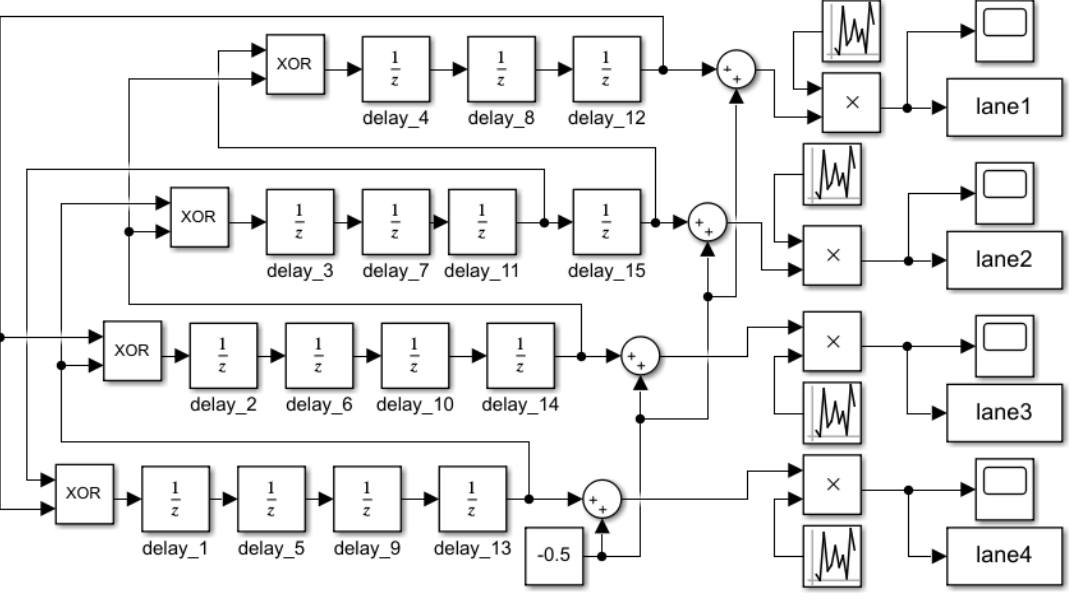
Appl. Sci. 2022 , 12 , x FOR PEER REVIEW Figure 12. Layout of Simulink code for PAPRBS generator. Figure 12. Layout of Simulink code for PAPRBS generator.